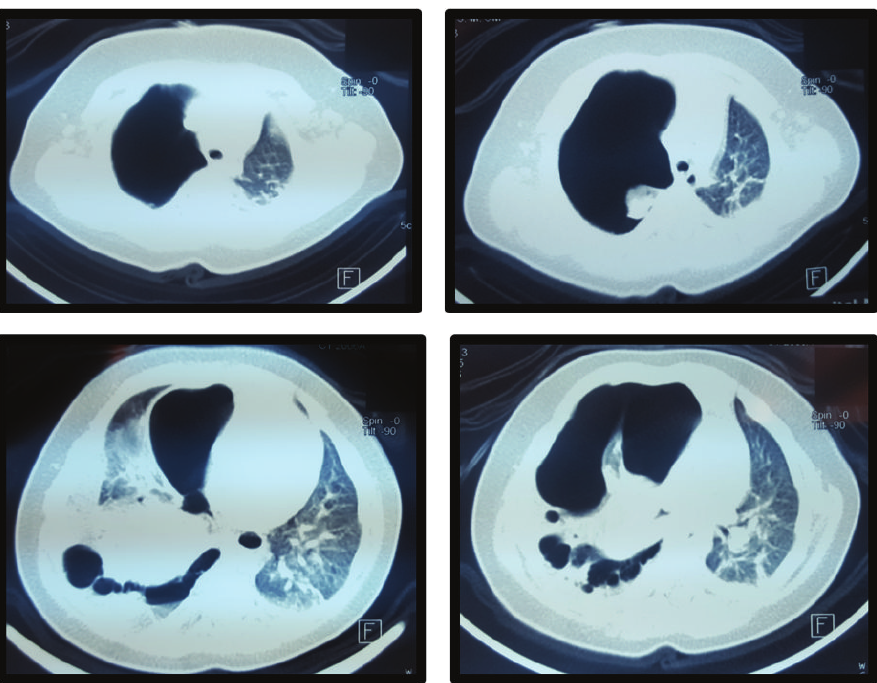
Figure 2: Chest CT scan.